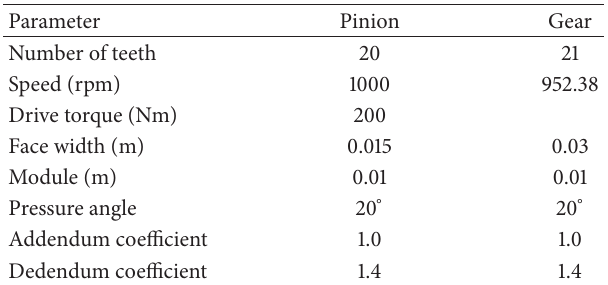
Table 3: Geared system data.